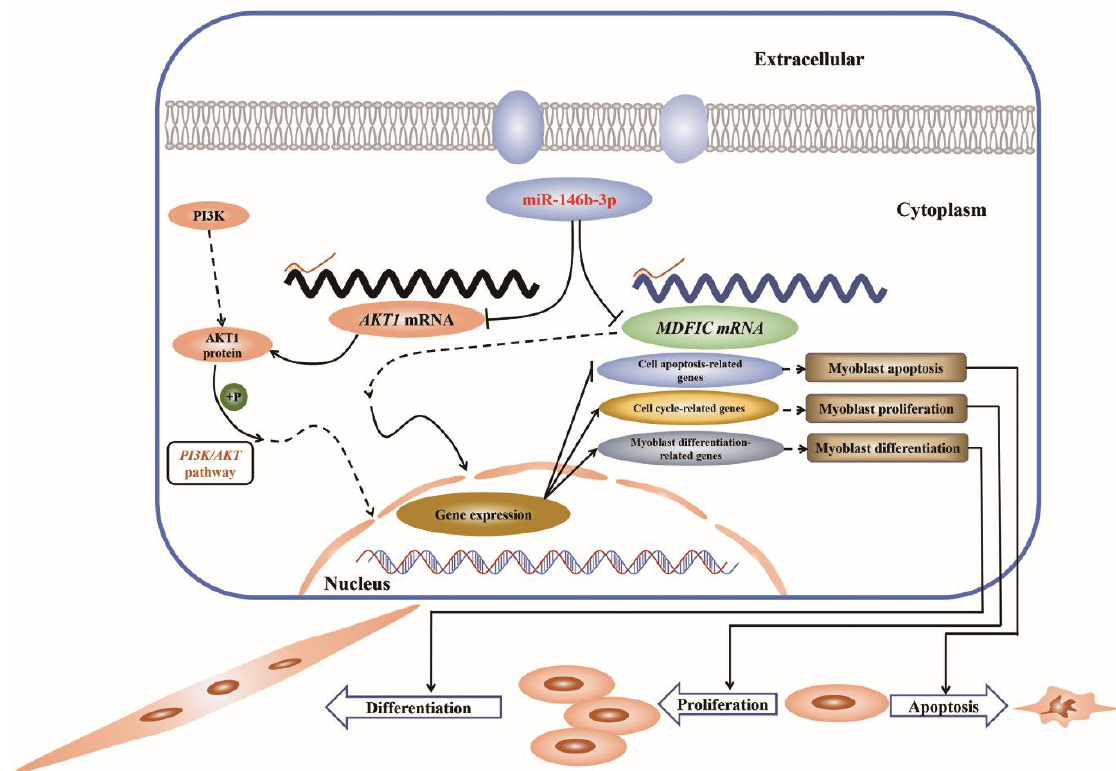
Figure 8. Model of miR-146b-3p mediated regulatory mechanism in myoblast proliferation, differentiation, and apoptosis. In simple terms, miR-146b-3p downregulates the expression of AKT1 and MDFIC by targeting the 3′UTR of their mRNA. Both the phosphorylation of AKT1 and AKT can trigger the activation of PI3K/AKT pathway, thereby promoting the expression of cell cycle-related genes and myoblast differentiation-related genes and suppress cell apoptosis-related genes, which in turn facilitate cell proliferation and differentiation and inhibit apoptosis. In addition, the expression of MDFIC can also lead to the same effect.